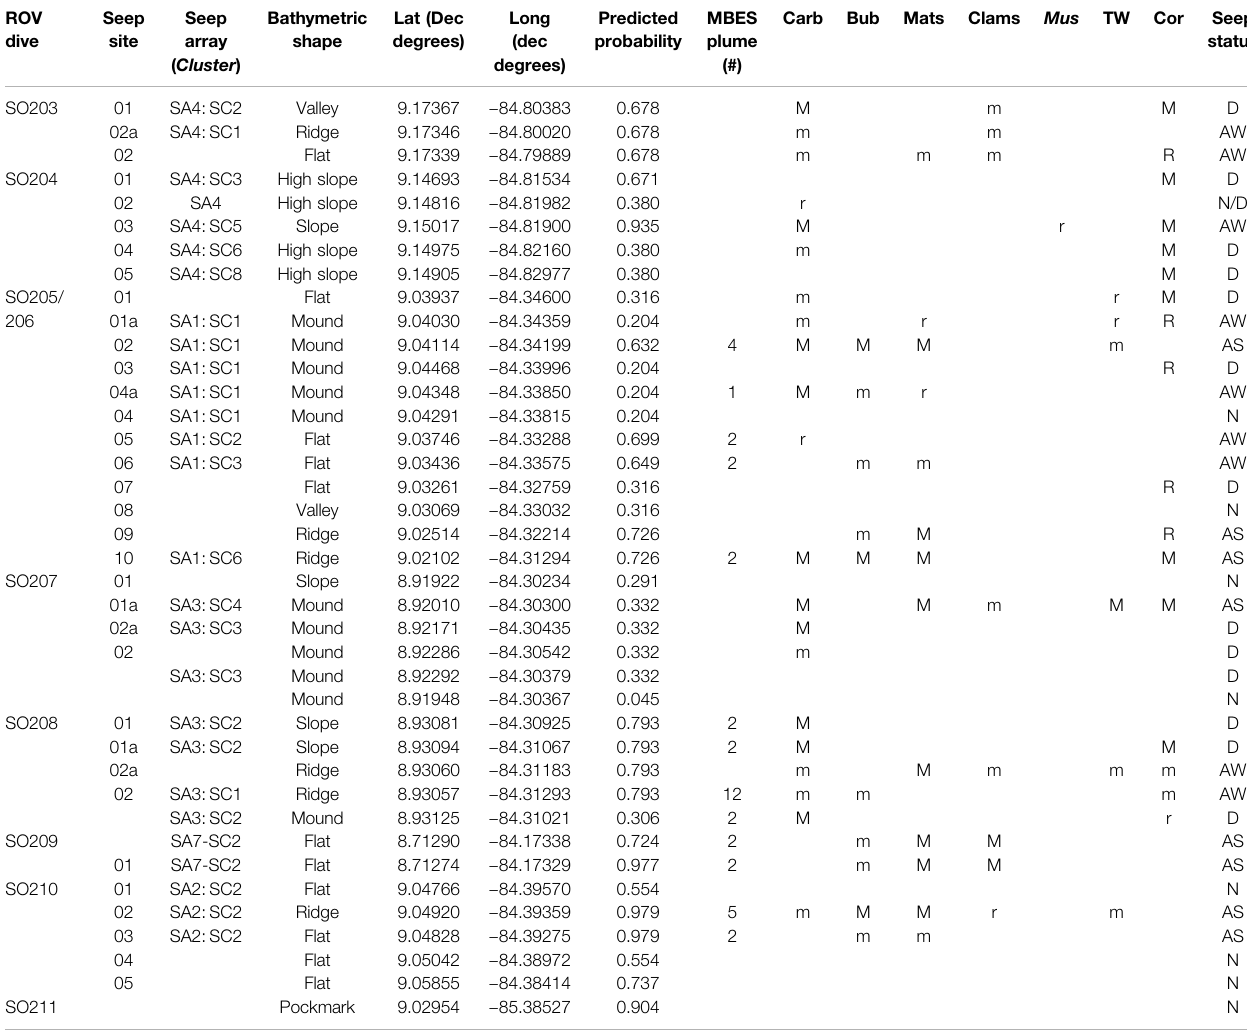
TABLE 1 | Summary of ROV seep